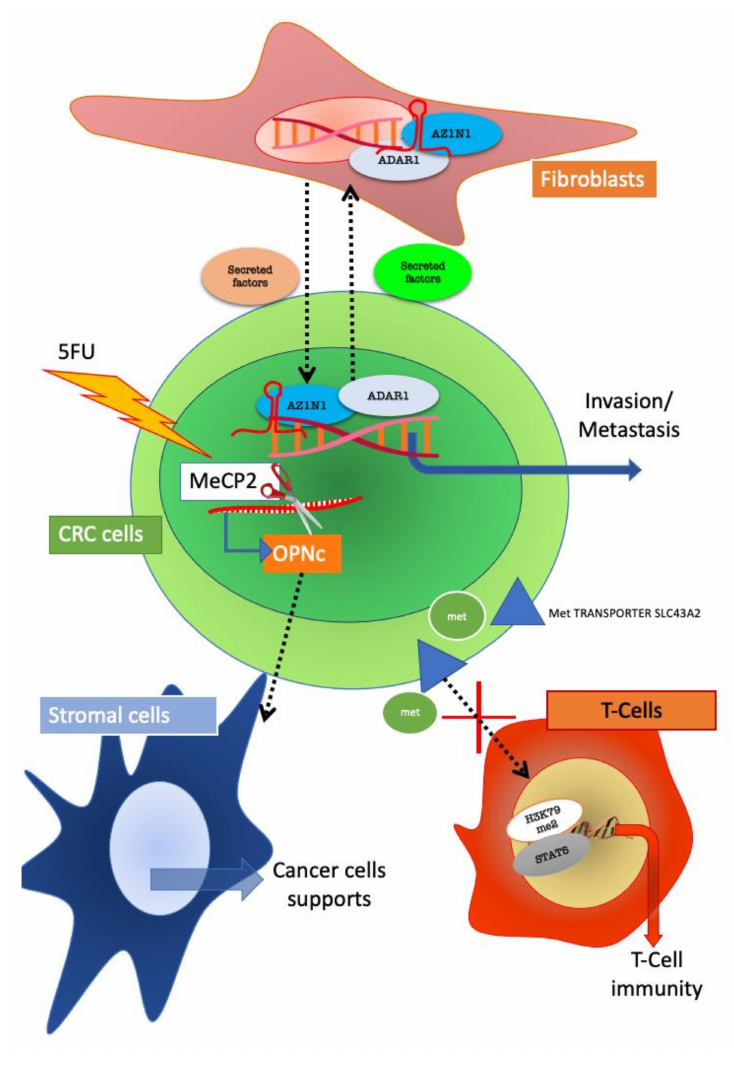
Figure 4. Reciprocal influences of colorectal cancer (CRC) and stroma cells mediated by epigenetic mechanism. CRC and fibroblasts interact through the ADAR1/AZIN1 (Adenosine deaminase acting on RNA 1/Antizyme Inhibitor 1) system and through this mechanism support tumour progression. In CRC resistant to 5FU, the isoform C of osteopontin (OPN) is selectively expressed; the isoform is produced by alternative splicing mediated by MeCP2 (methyl CpG binding protein 2). Secreted OPNc influences surrounding stromal cells towards sustaining tumour growth. CRC cells can also impede T-cell immunity by methionine subtraction which leads to H3K79m2/STAT5 inactivation in T